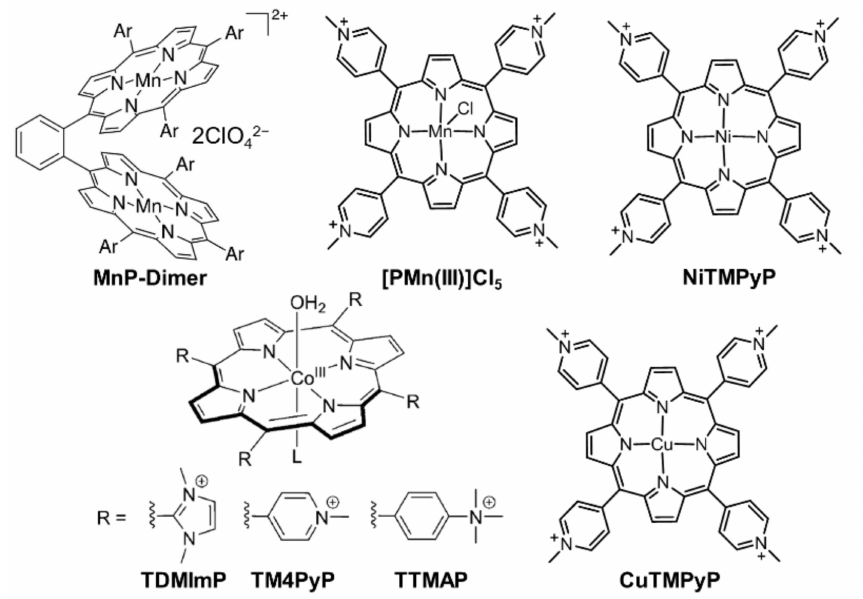
Figure 2. Chemical structures of porphyrin-based small molecules as homogeneous catalysts for electrocatalytic OER. Reproduced from refs.